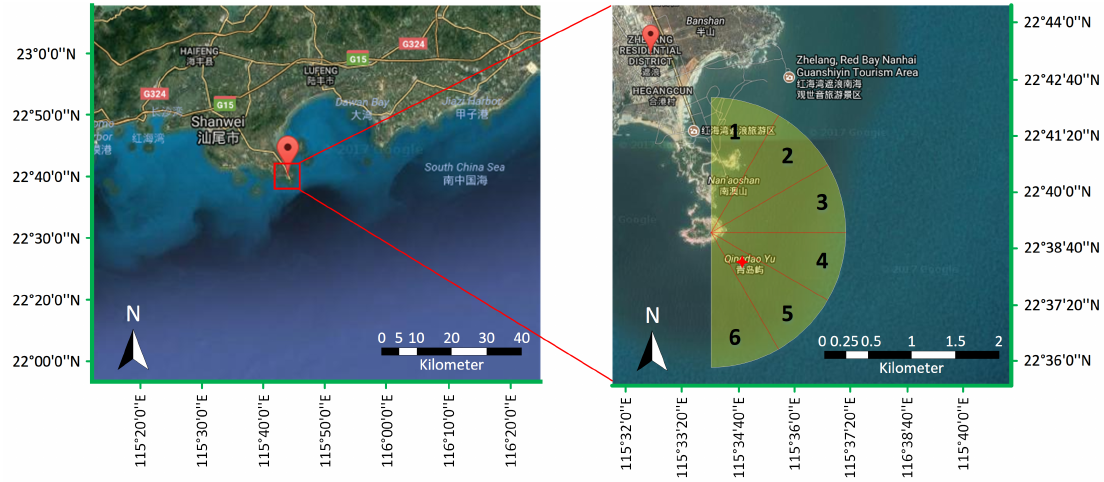
Figure 8. Position of experiment. The red rectangle marks the location where MORSE is and the right part of this figure gives the antennas’ orientation. The red star indicates the location of the Waverider